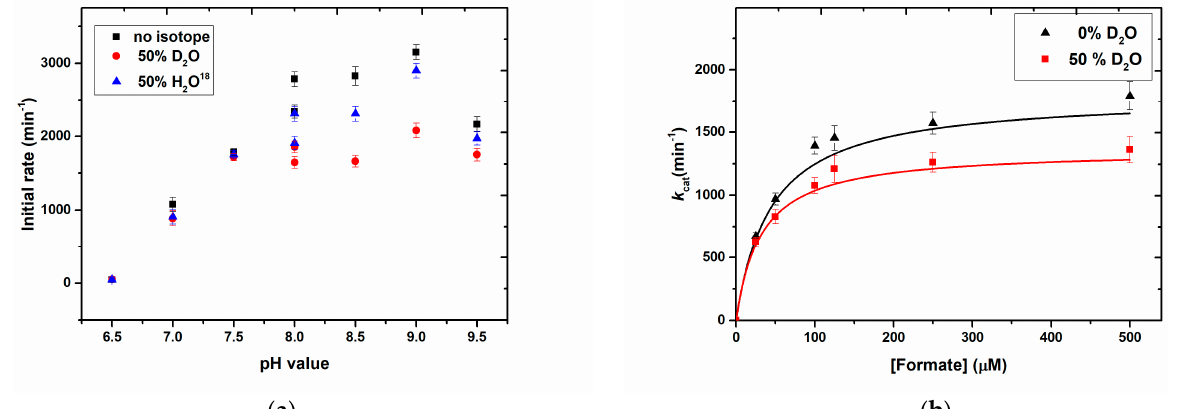
Figure 2. ( a ) Kinetic solvent isotope effect at different pH using 50% D 2 O and 50% H 218 O. The shown ratios were obtained at different pH values. Phosphate buffer (100 mM) for pH 6.5–8.0 and Tris-HCl buffers (100 mM) for pH 8.0–9.5 were used. ( b ) . Kinetic solvent isotope effect on steady-state kinetics using H 2 O with 0% and 50% D 2 O. Reaction mixture contained 2 mM NAD + and formate (50–500 µM) in phosphate buffer (100 mM, pH 7.9). The measurement at 340 nm was started after adding Rc FDH (50 nM). pH and pD values were corrected, as per the literature [7,33]. Table 1. Ratios of initial rate constants using unlabeled water versus 50% deuterium oxide (D 2 O) or